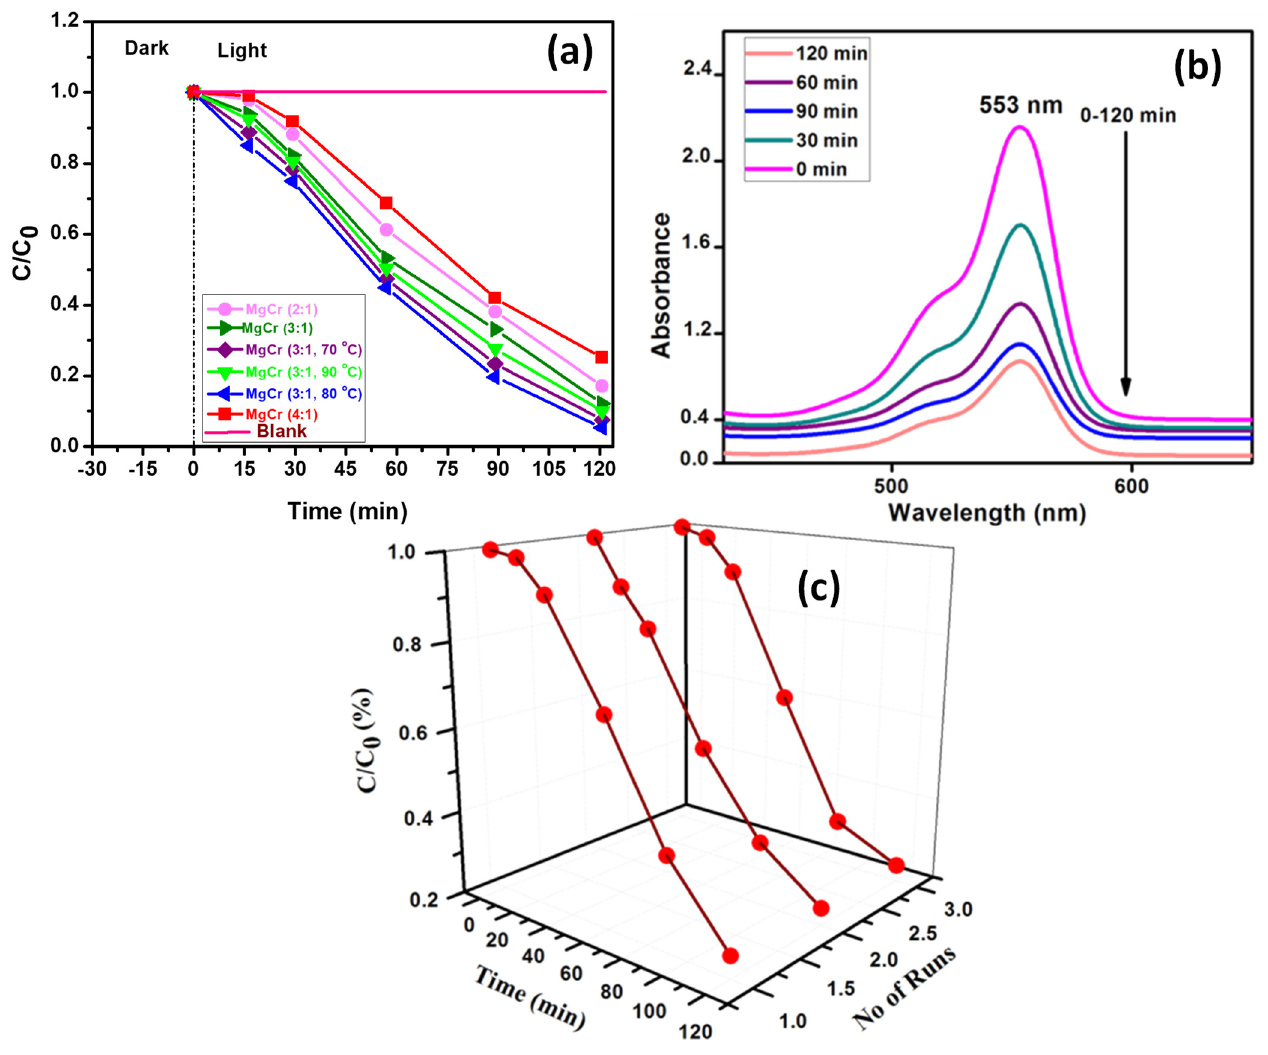
Figure 6. ( a ) Photocatalytic degradation rate of RhB over variant of MgCr − LDH samples. ( b ) Spectral alteration of RhB absorption in different time interval by MgCr 3:1, 80 °C. ( c ) Stability test of MgCr 3:1, 80 °C for three different cycles.